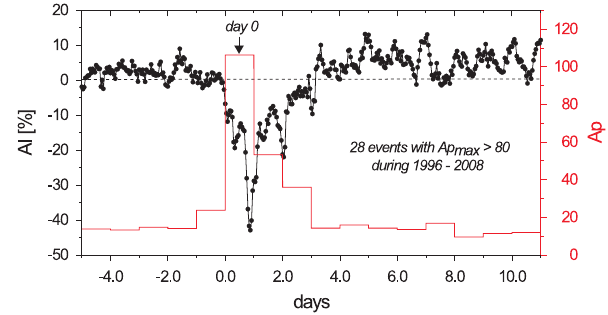
Fig. 16. Mean variation of the hourly AI values (black) and of the daily geomagnetic Ap values (red) derived from 28 individual iono- spheric storms with maximum Ap values ≥ 80 during the time inter- val from 1996 until 2008 by a superimposed epoch